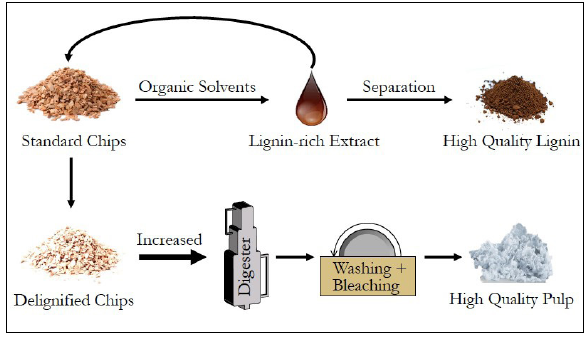
Wood bulk biomass conversion into high-quality pulp solid state material.